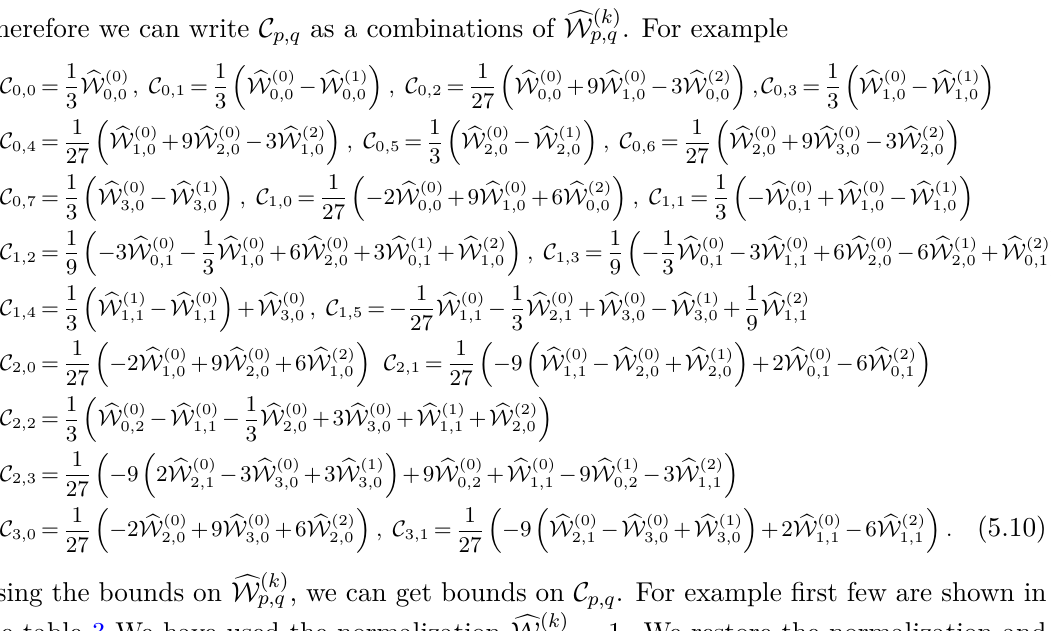
Table 3 . Bounds on C p,q . Note that c W ( k ) contains the subtraction constants c W ( k ) and get the two sided bounds in terms of c W ( k ) and use in equation